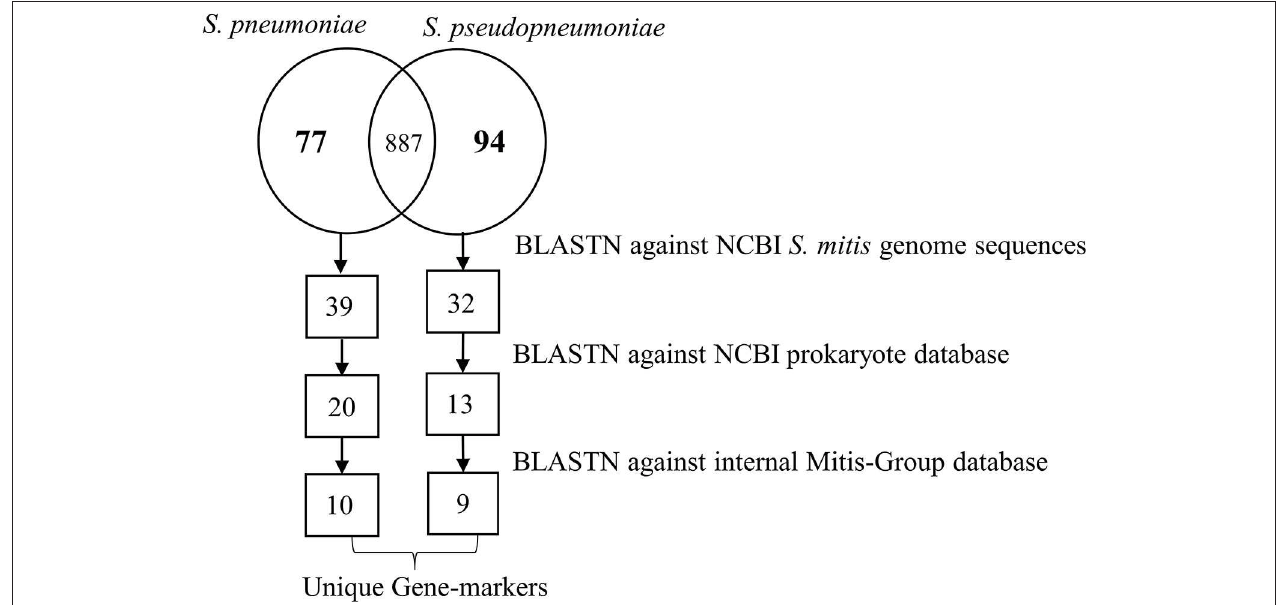
FIGURE 3 | Schematic representation of the number of unique genes found at each step of the analysis for identifications of specific unique biomarkers for S. pneumoniae and S. pseudopneumoniae .